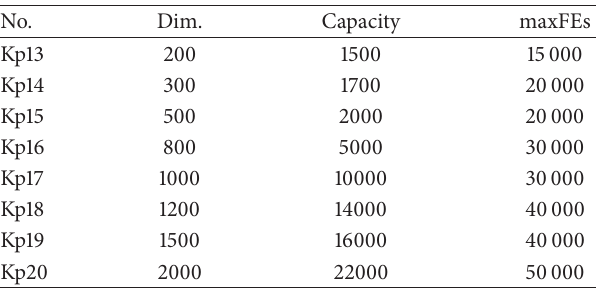
Table 3: The parameters of the high-dimensional 0-1 knapsack